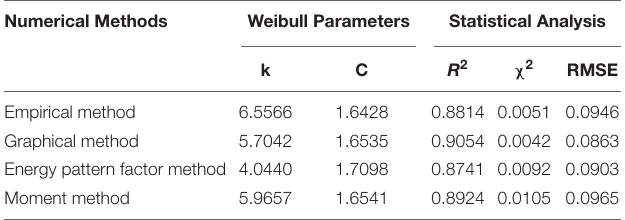
TABLE 3 | Weibull parameters and statistical test, year 2012.